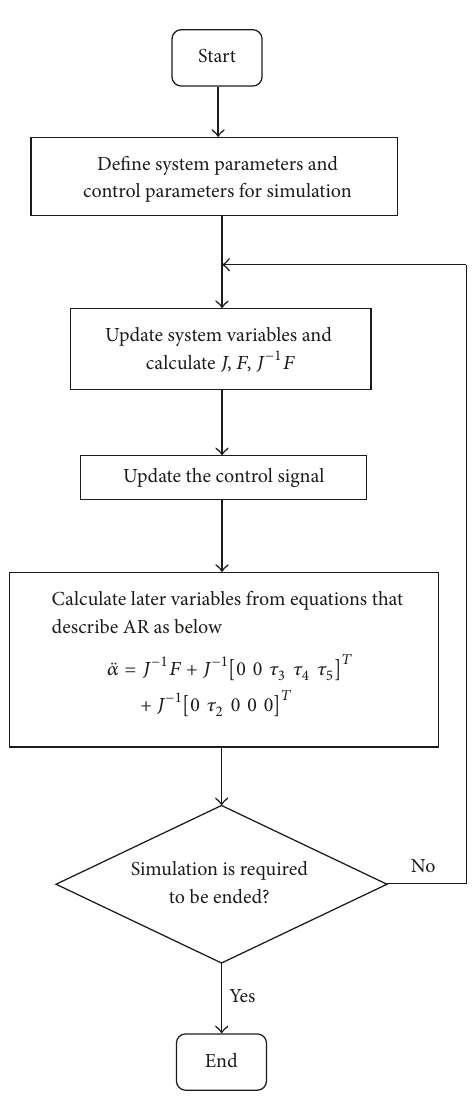
Figure 10: Simulation